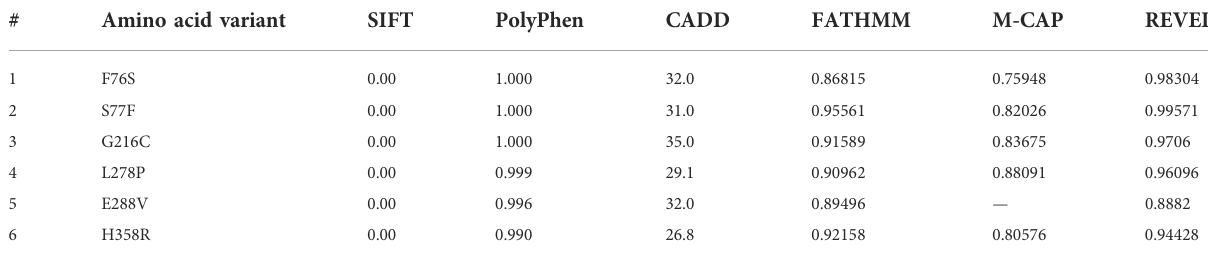
TABLE 2 The pathogenicity prediction output of different computational tools of the SERPINA1 missense variants.